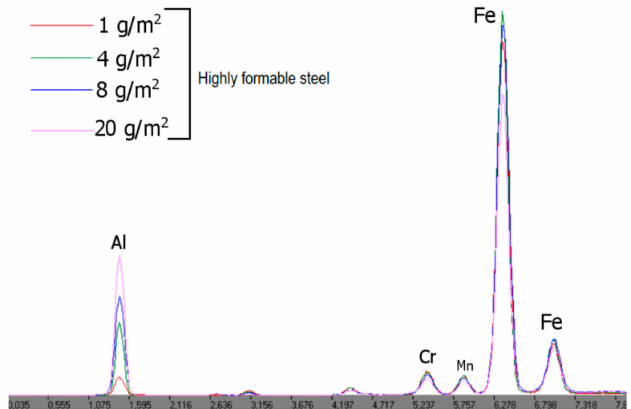
Figure 3. XRF spectra of calibration samples with di ff erent Al coating thickness on highly formable steel